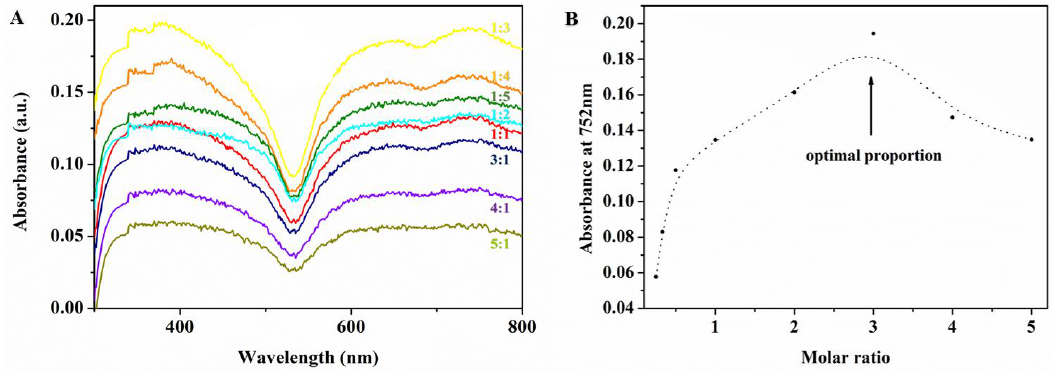
Figure 3. ( A ) UV-vis spectra of different volume ratios (CUR/PC); ( B ) absorbance at 752 nm of different volume ratios (CUR/PC).